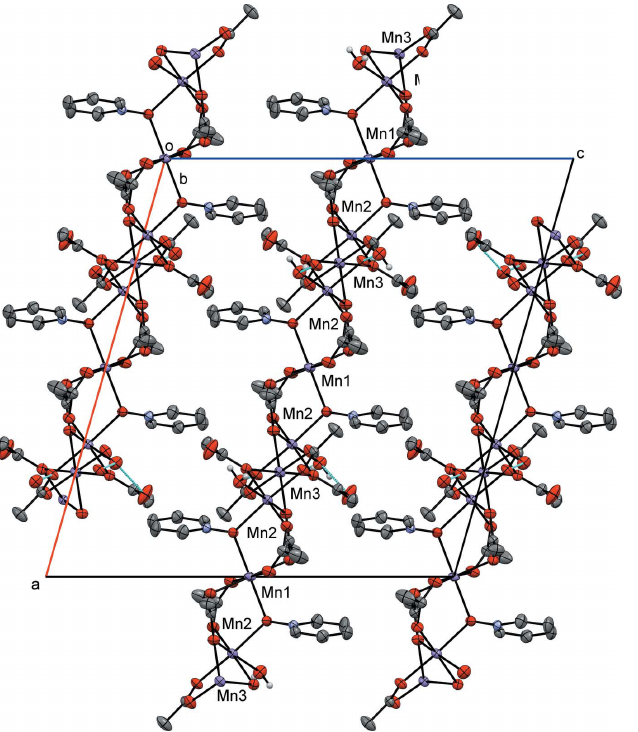
Figure 4 Crystal packing diagram of compound I , viewed along the b axis. Displacement ellipsoids are drawn at the 50% probability level, H atoms not involved in hydrogen bonding have been omitted for clarity, hydrogen bonds are rendered in blue.